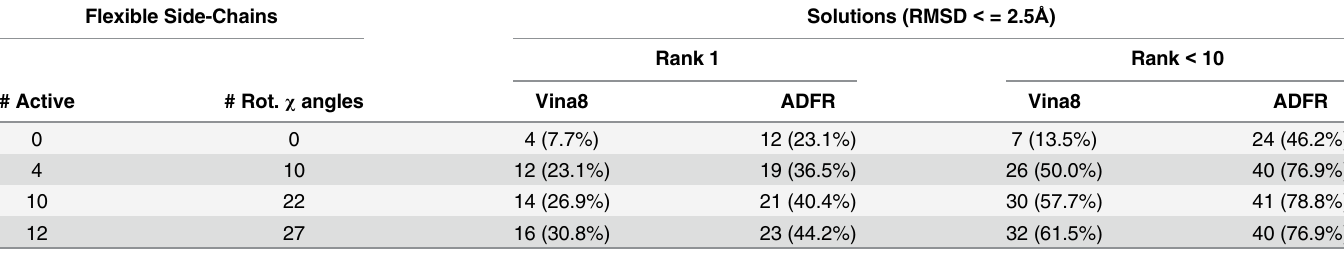
The left section ( “ Flexible side-chains ” ) show the number of side-chains considered fl exible in each docking and the corresponding number of rotatable χ angles. The right section reports the number of systems (and percentage) for which the ligand-RMSD of the lowest energy solutions found by ADFR and AutoDock Vina are less than 2.5 Å (rank 1) or a correctly docked solution is within the 10 top solutions (rank <